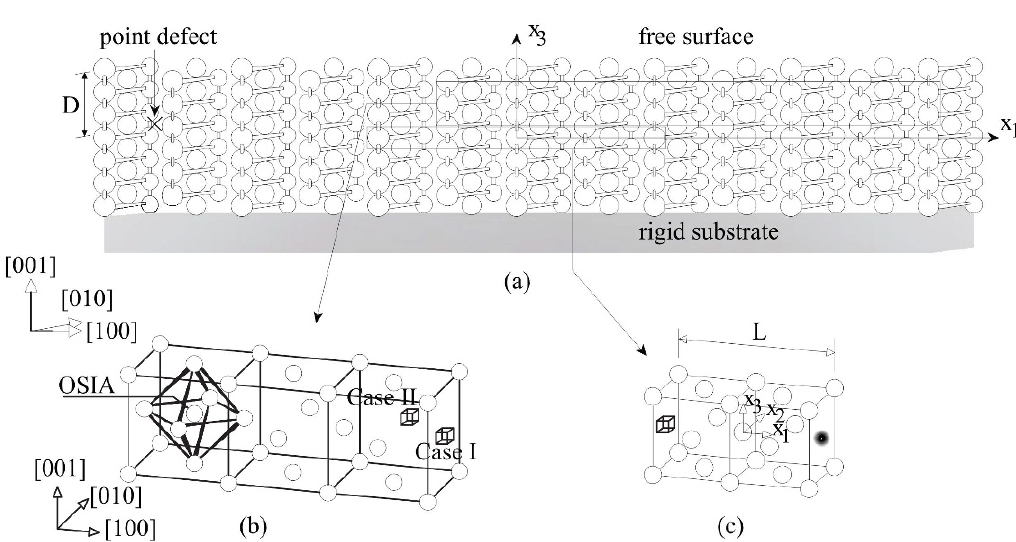
Figure 1. (a)Thenomenclatureofanfccthinfilmcontainingapointdefectmarkedas × atthedistance D fromthefreesurface,(b)theconfiguration of OSIA-vacancy for two different positions, indicated as case I and case II, and (c) a dopant-vacancy ensemble.